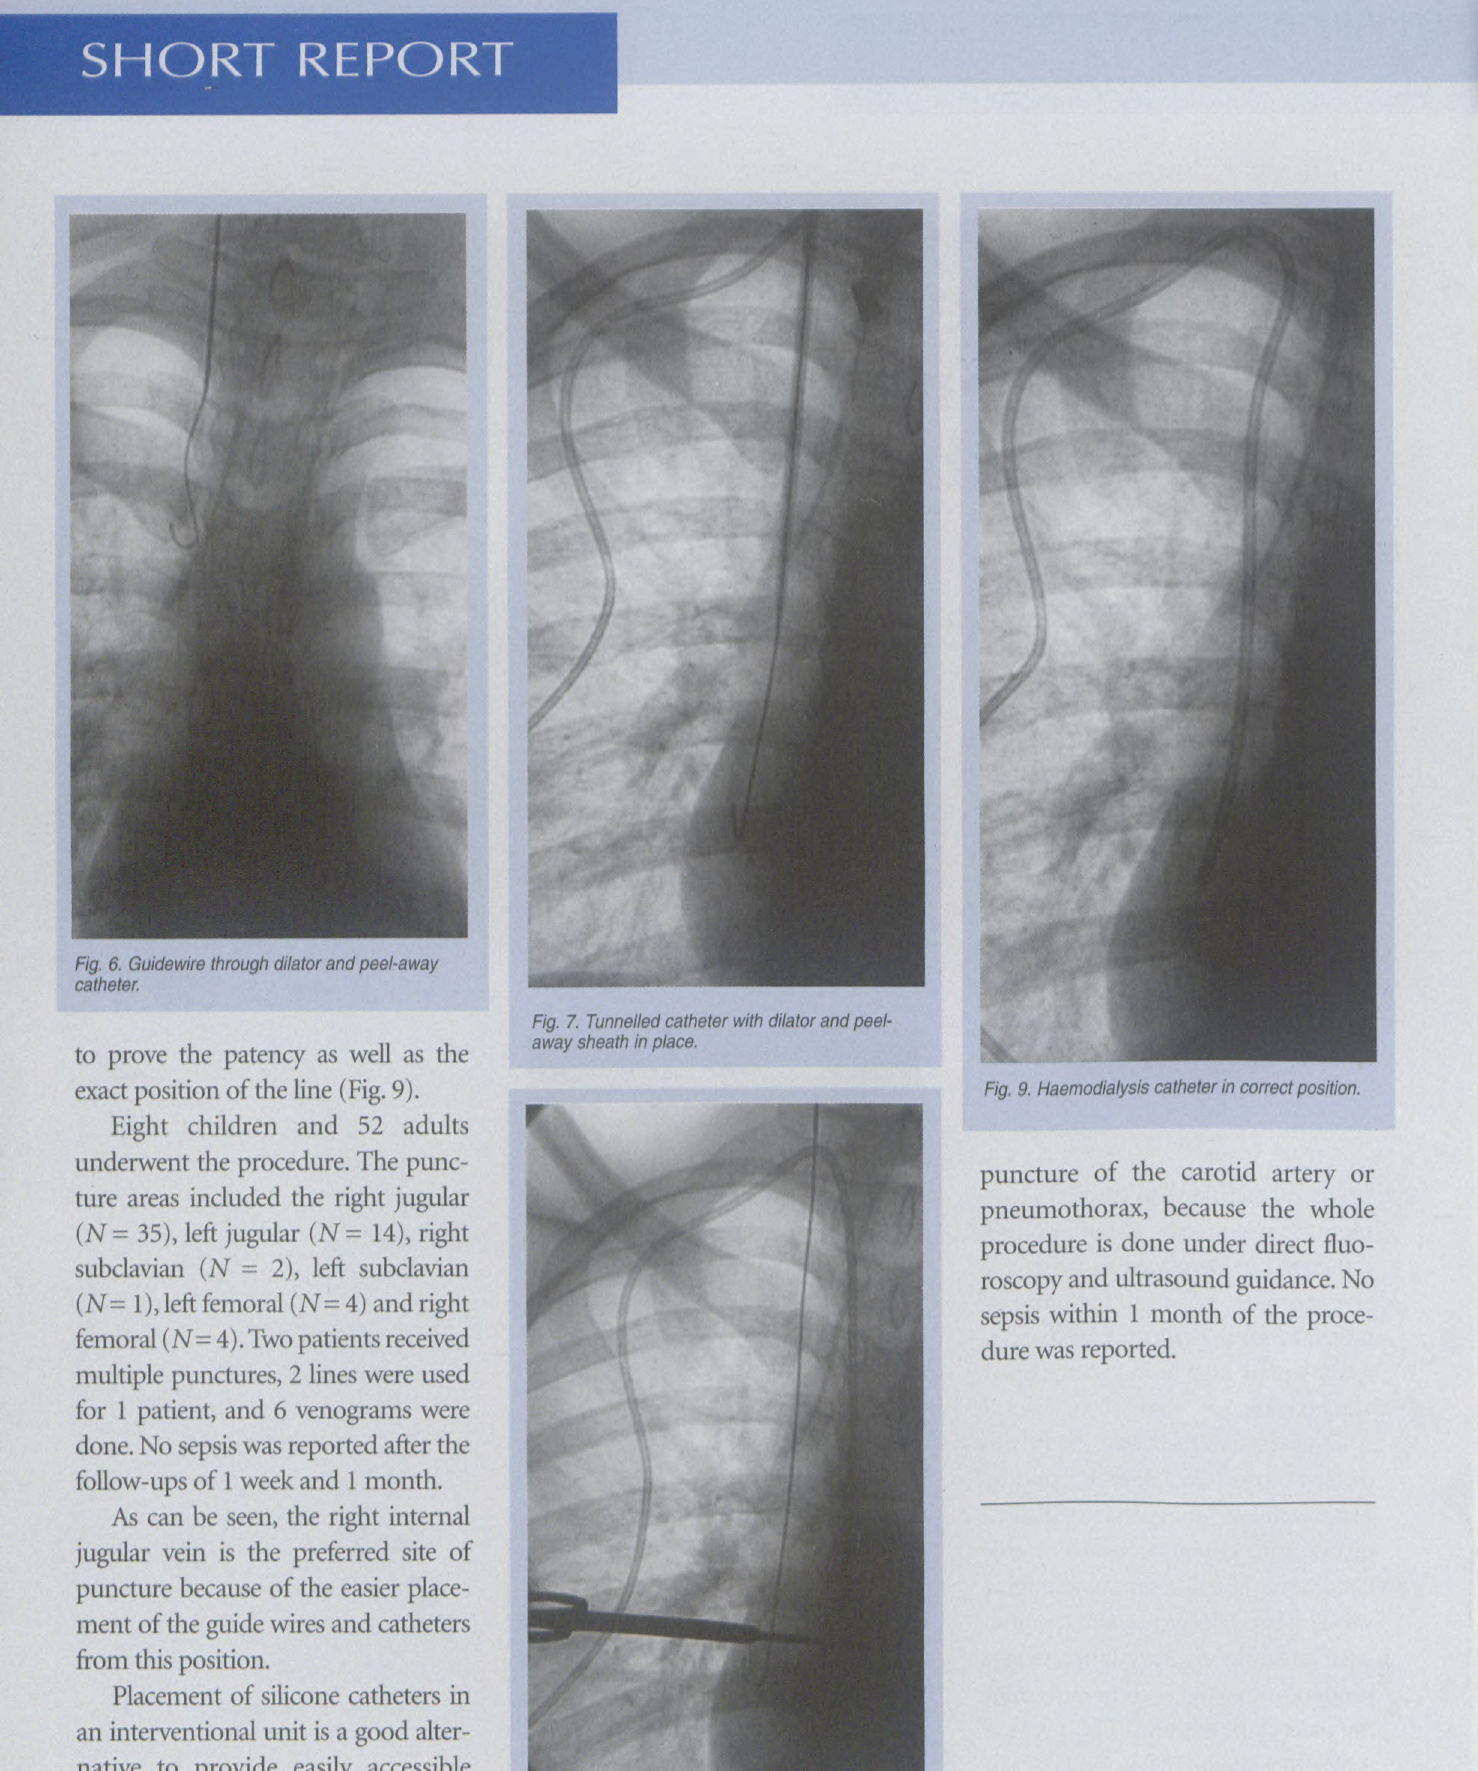
Fig. 8. Determine the length of the catheter.